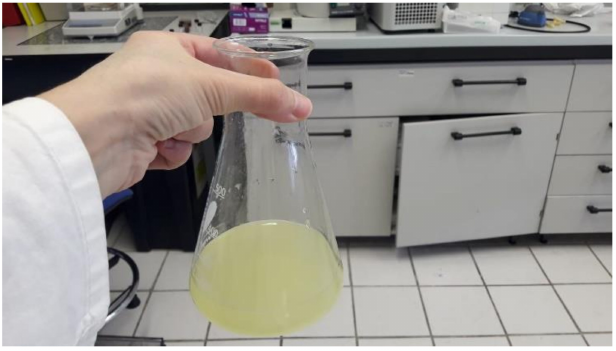
Figure 4. The yellow aqueous solution following hydrodynamic cavitation of waste lemon peel (image courtesy of Dr. M. Pagliaro,